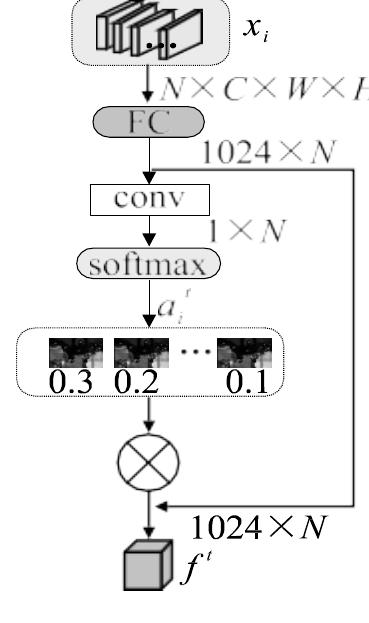
Figure 3. Temporal attention model based on CNN